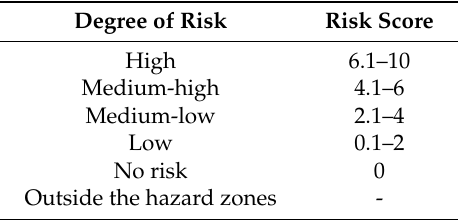
Table 7. Risk scores for each natural